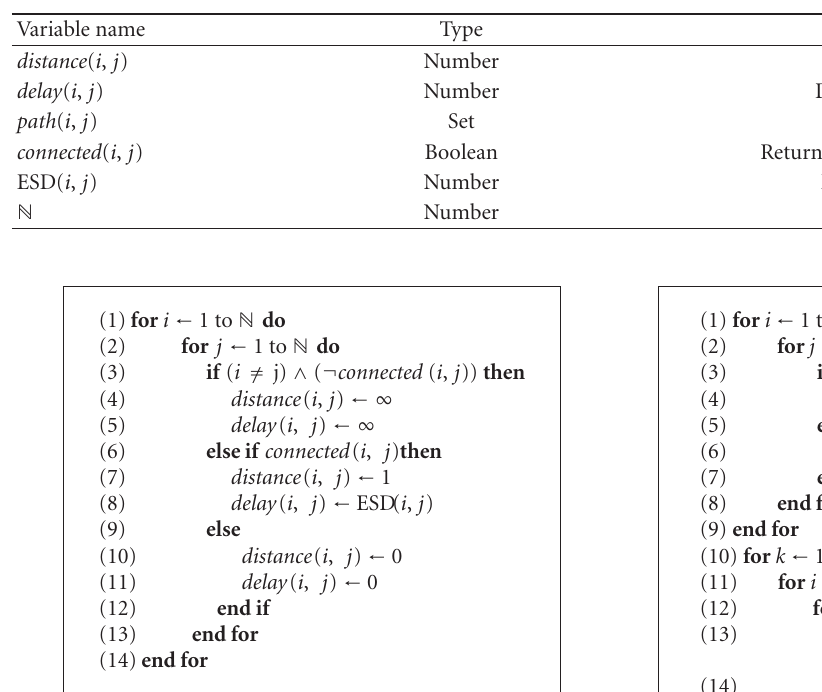
Table 2: State variables at each node i .